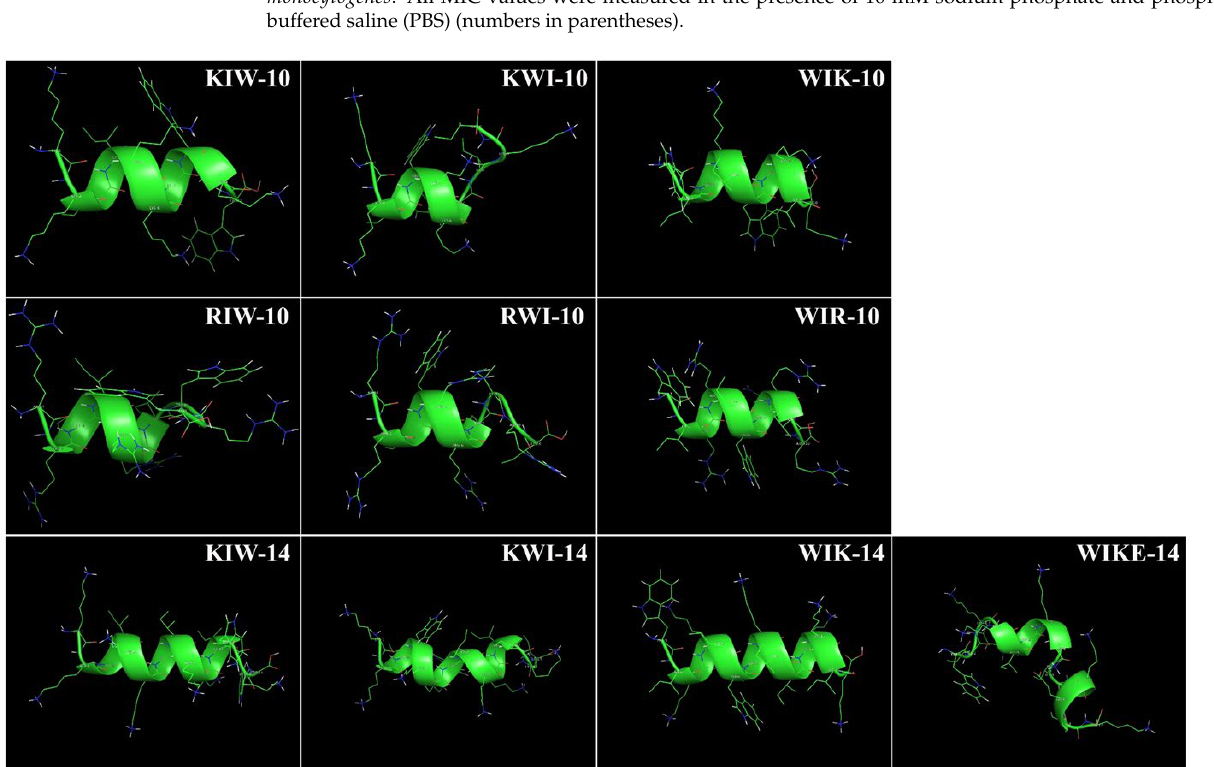
GIGAVLKVLTTGLPALISWIK- RKRQQ-NH 2 * Ec: Escherichia coli ; Pa: Pseudomonas aeruginosa ; Sa: Staphylococcus aureus ; Bs: Bacillus subtilis ; Lm: